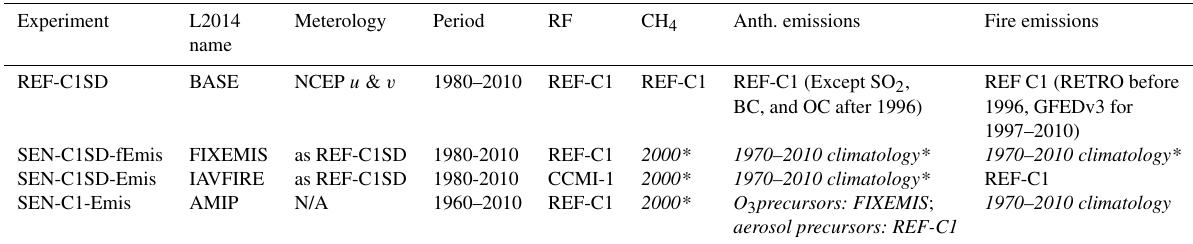
Table B1. Summary of forcings and emissions data used in the GFDL-AM3 hindcast simulations, with italics indicating where the data differ from the CCMI-1 recommendations. L2014 = Lin et al.